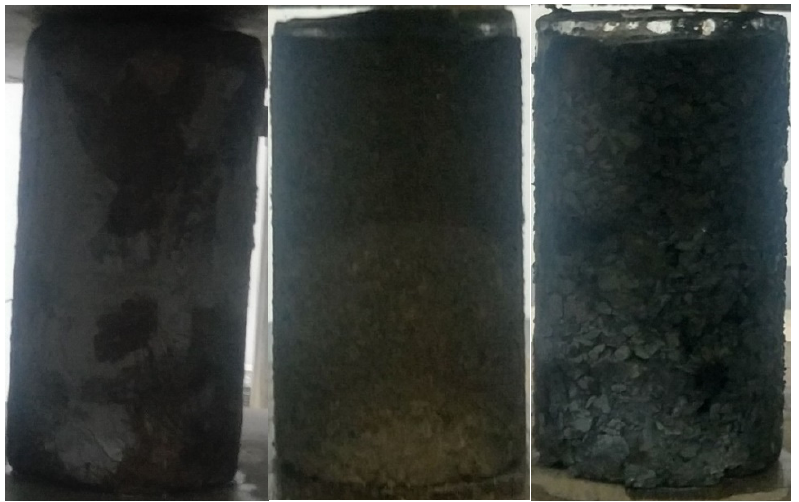
Figure 2. Frozen soil specimens before uniaxial compression tests (clay, sand, and gravel from left to right).